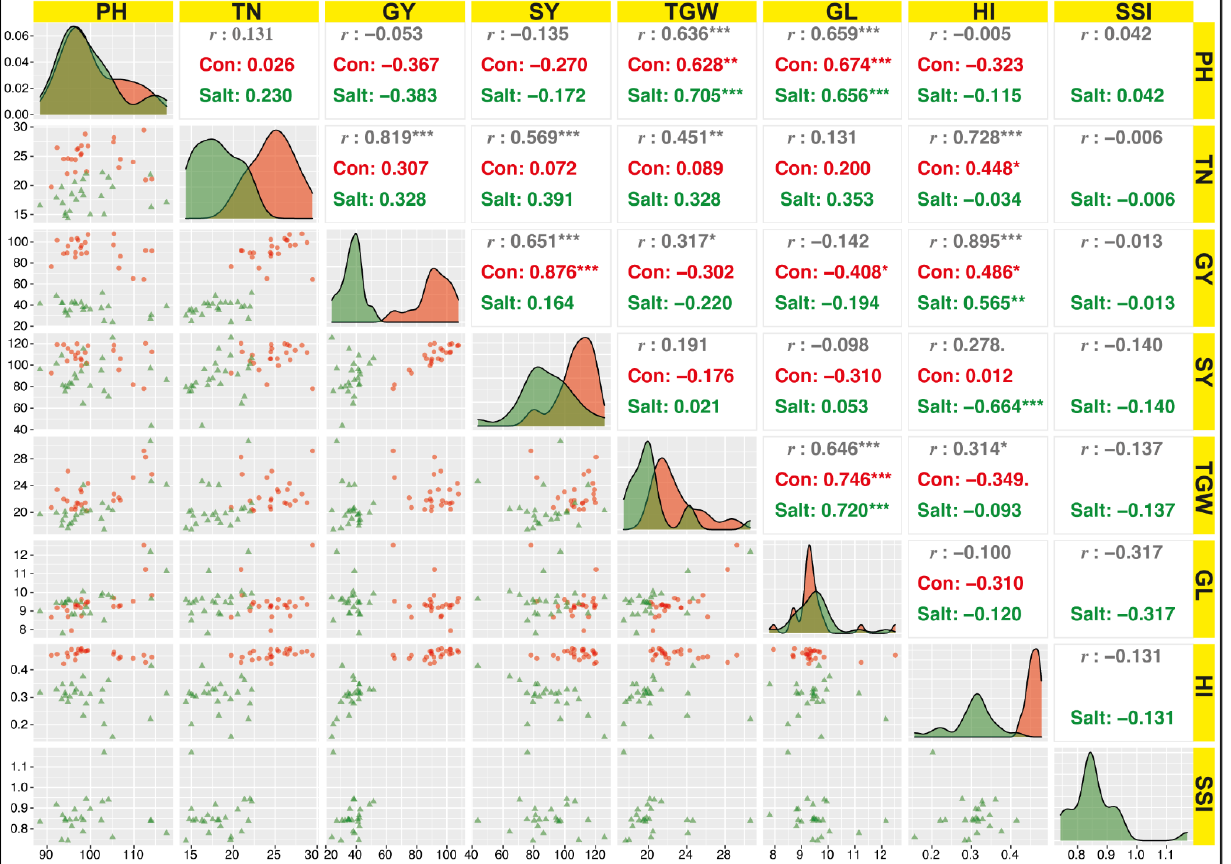
Figure 5. Correlation between seven morpho-physiological traits of rice genotypes at maturity stage. Plants were evaluated in control (Con) and salt stress (Salt) under field conditions. PH = plant height (cm); TN = tillers number; GY = grain yield/plant (g); SY = straw yield (g); TGW = 1000-grain weight (g); GL = grain length (mm); HI = harvest index (%). *** Highly significant ( p < 0.001); ** Highly significant ( p < 0.01); * significant ( p < 0.05).